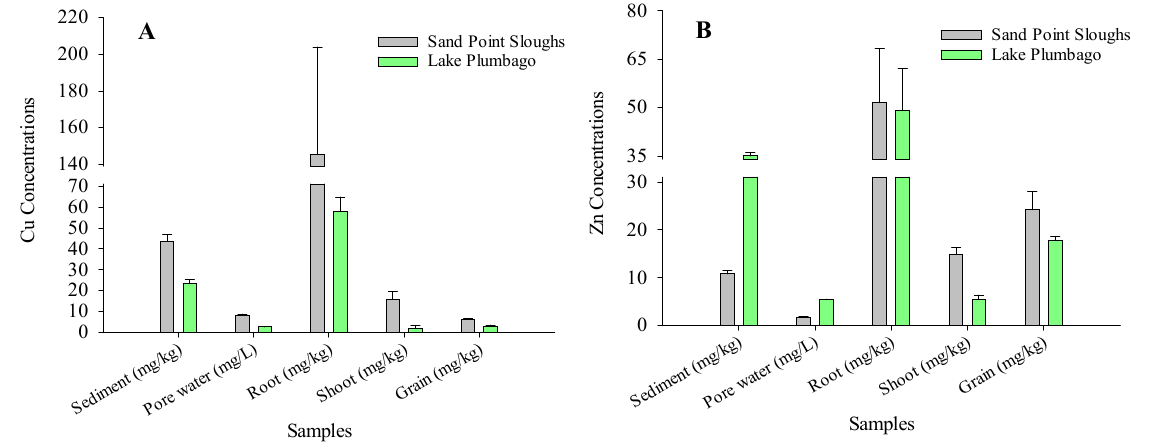
Figure 2. Total element concentrations in Sand Point sloughs and Lake Plumbago sediment, porewa- ter, and wild rice samples. The concentrations are expressed as mg/kg for sediment and plant sam- ples and mg/L in water samples. ( A ). Arsenic, ( B ). Mercury, ( C ). Cadmium, and ( D ). Chromium. Data are reported as mean ± S.D. ( n = 3).